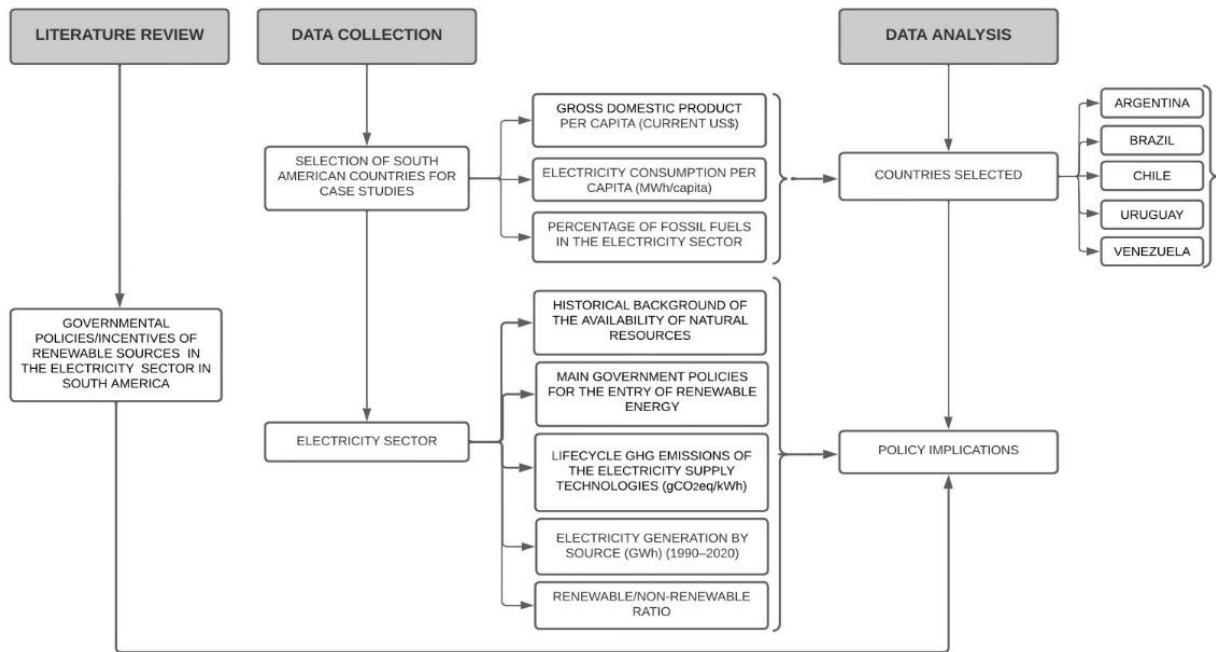
Figure 1. Methodological procedures.